Question: Judging by this figure, is the value going up or going down?
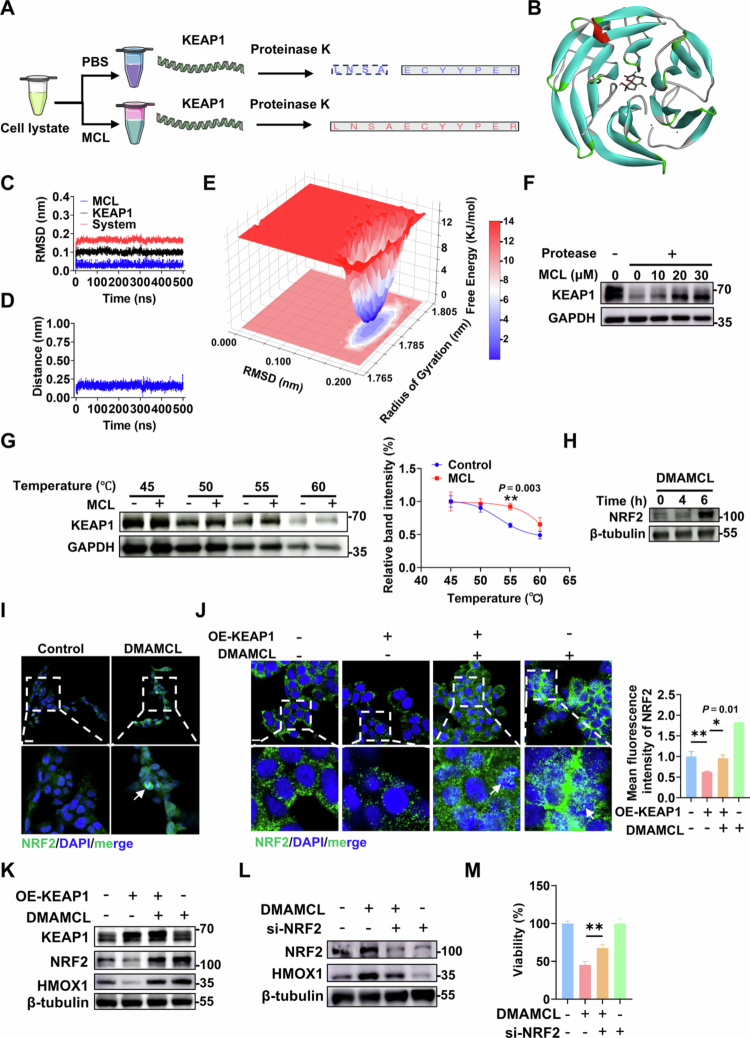
Answer: increasing